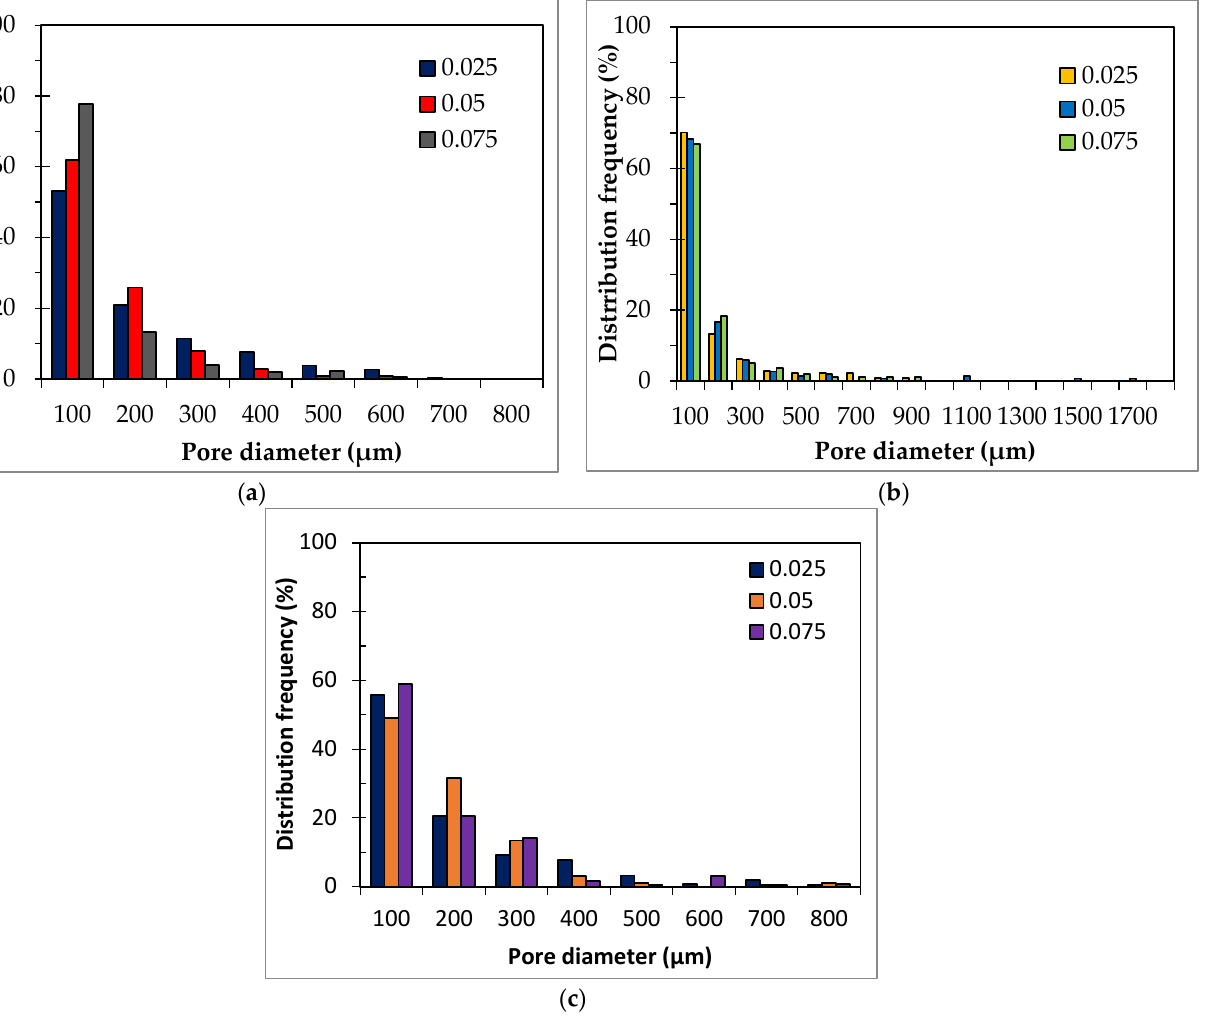
Figure 6. Pore size distribution (measured by image analysis of the SEM images shown in Figure 5) of GFs prepared with 0.05 wt.% Al, and 0.025, 0.05 and 0.075 wt.% surfactants: ( a ) Hostapur OSB, ( b ) SDS, and ( c ) Triton X114.